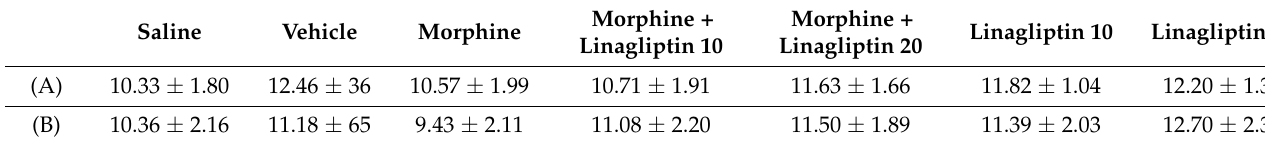
Table 2. The influence of linagliptin (10 and 20 mg/kg, ip) administered during morphine withdrawal on the locomotor activity of mice observed in the elevated plus maze test during: (A) short-term (60 h) and (B) long-term (14 days) morphine withdrawal.